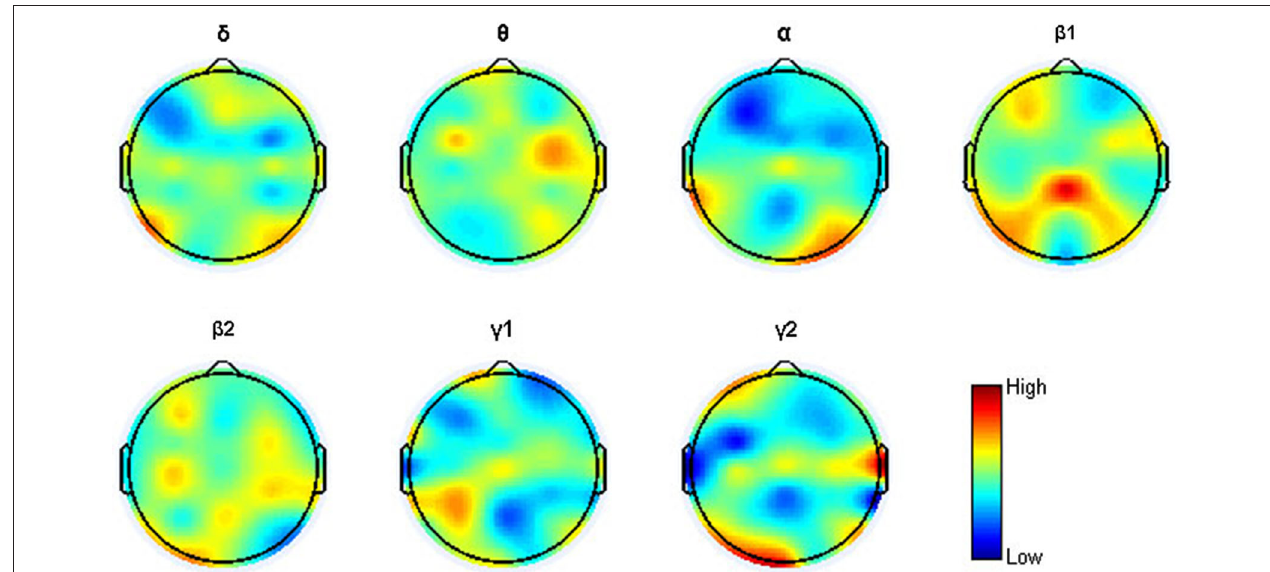
FIGURE 5 | Topographic mapping of the quantified feature contributions averaged across 17 subjects for the 7 frequency bands